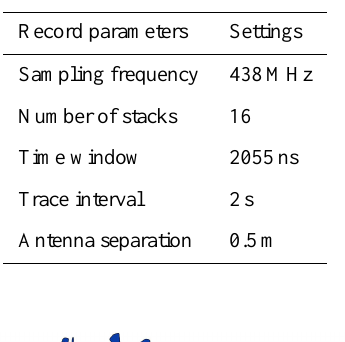
Table 3. GPR settings.